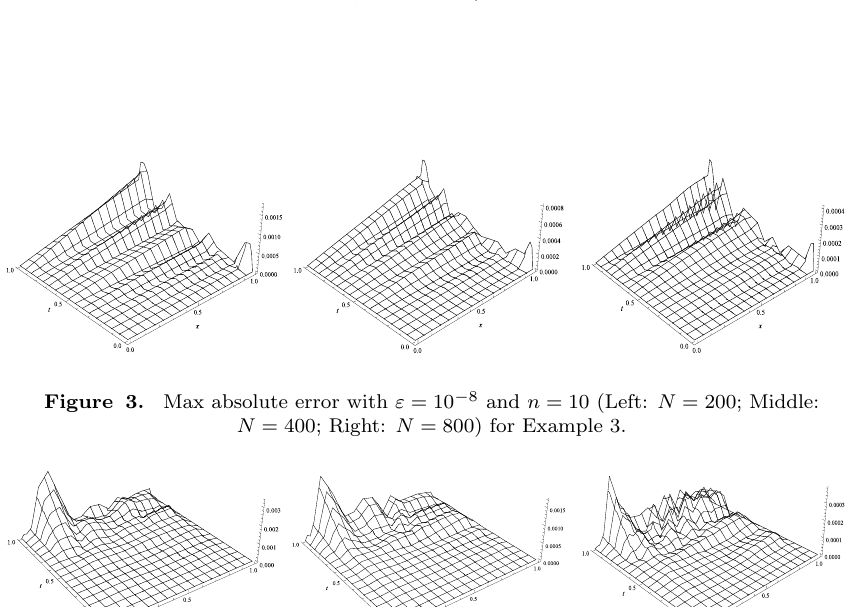
Figure 2. Max absolute error with ε = 10 − 6 and n = 10 (Left: N = 200; Middle: N = 400; Right: N = 800) for Example 2.